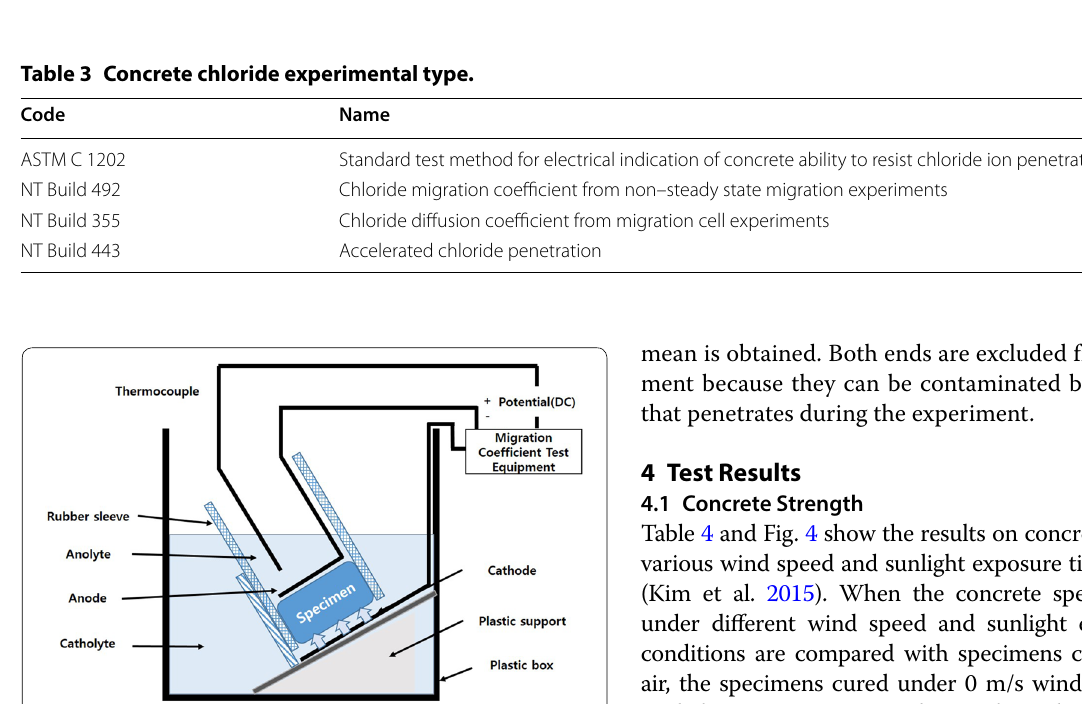
Fig. 2 NT Build 492 test